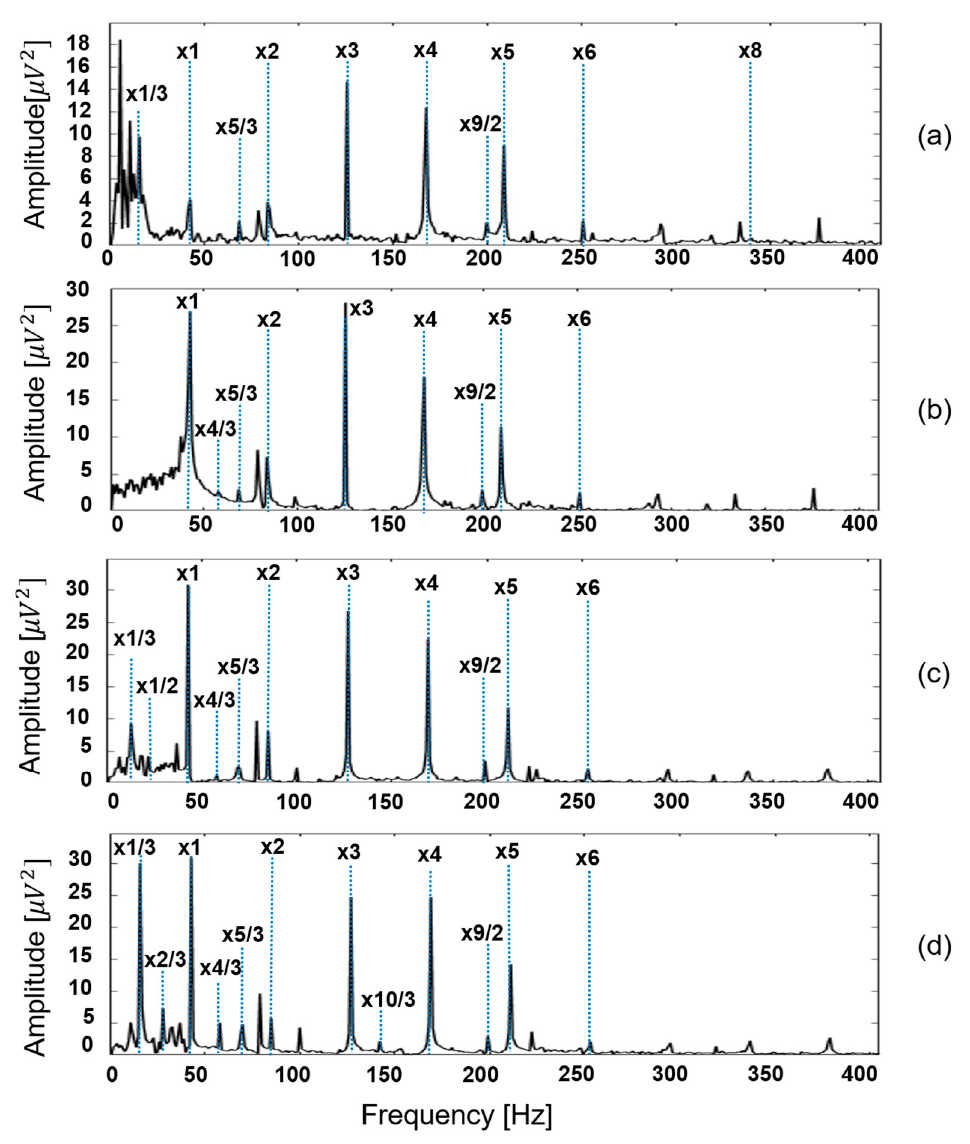
Figure 7. Envelope power spectra of reconstructed signals obtained using EEMD and the proposed IMF selection technique for classes ( a ) ‘0.0 g’; ( b ) ‘1.6 g’; ( c ) ‘2.0 g’; and ( d ) ‘2.8 g’.